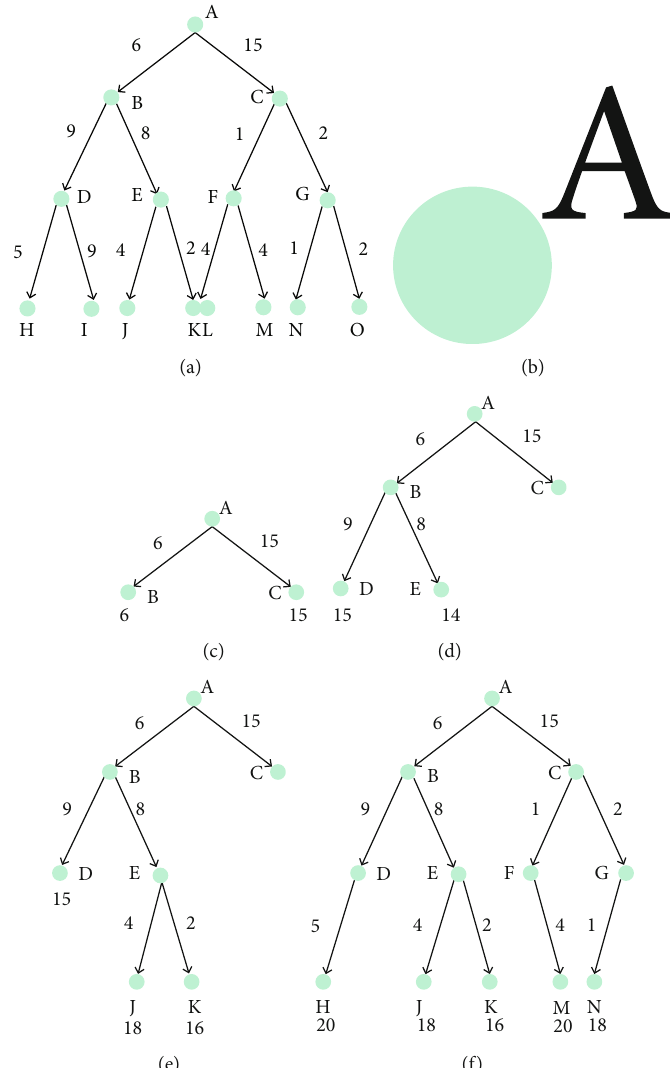
Figure 1: Branch and bound method satisfying H ∗ ð P Þ = 0